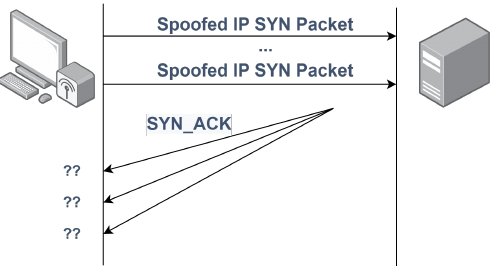
Figure 3. Conceptual diagram of the TCP SYN Flood attack. The attacker uses spoofed IP addresses, so the victim never gets a response to the SYN-ACK packets, forcing it to keep open ports and exhausting its